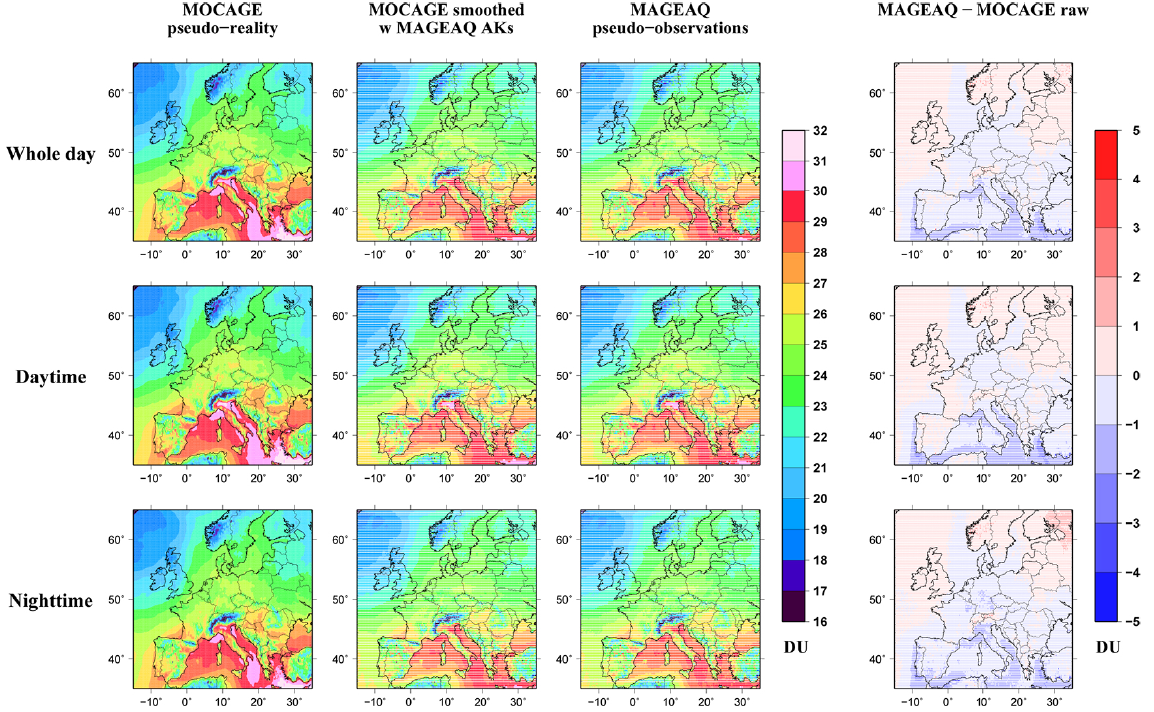
Fig. 4. Average surface–6km TOC for 5–28 August 2009. From left to right: raw and AK -smoothed MOCAGE pseudo-reality, MAGEAQ- TIR pseudo-observations, differences of MAGEAQ-TIR pseudo-observations with respect to raw MOCAGE pseudo-reality. The average TOCs are reported for the whole day (top row), daytime (central row) and night time acquisitions (bottom row).